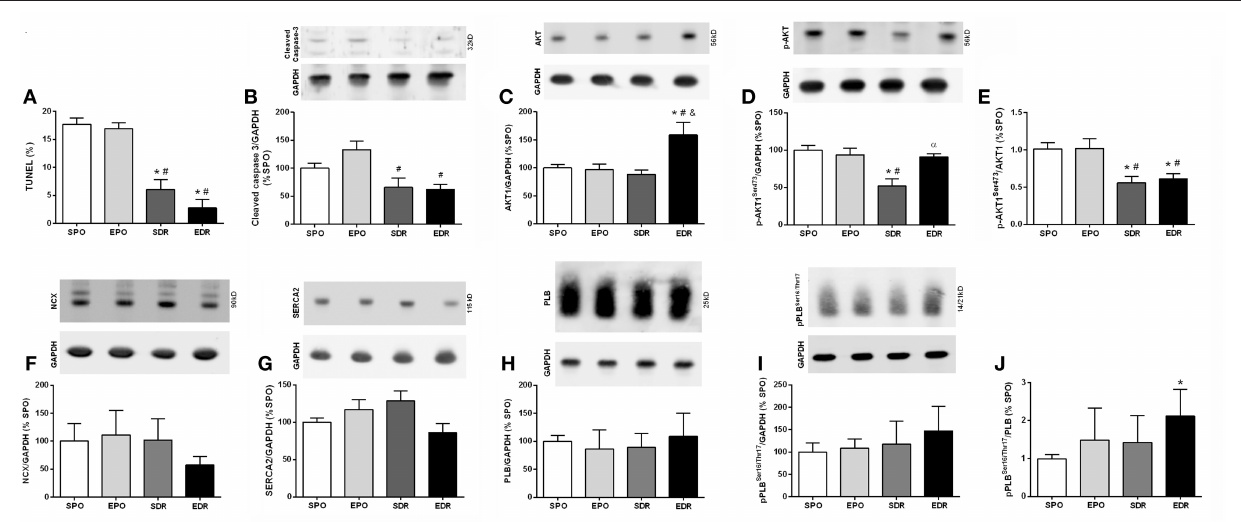
FIGURE 3 | Apoptosis and calcium kinetics in sedentary permanent occlusion (SPO), exercised permanent occlusion (EPO), sedentary delayed reperfusion (SDR), and exercised delayed reperfusion (EDR) groups. (A) Percentage of apoptotic cells by TUNEL analysis. (B) Cleaved caspase-3. (C) AKT1. (D) Phosphorylated AKT1 (pAKT1). (E) Ratio of pAKT1/AKT1. (F) Sodium calcium exchanger (NCX). (G) SERCA2. (H) Phospholamban (PLB). (I) Phosphorylated PLB (pPLB) at serine (ser) 16 (PLB ser16) and threonine (thr) 17 (PLB thr 17). (J) Ratio of pPLB/PLB. Differences were evaluated by two-way ANOVA followed by post-hoc Bonferroni test. * p < 0.05 vs. SPO; # p < 0.05 vs. EPO; & p < 0.05 vs. SDR; α p < 0.05 vs.